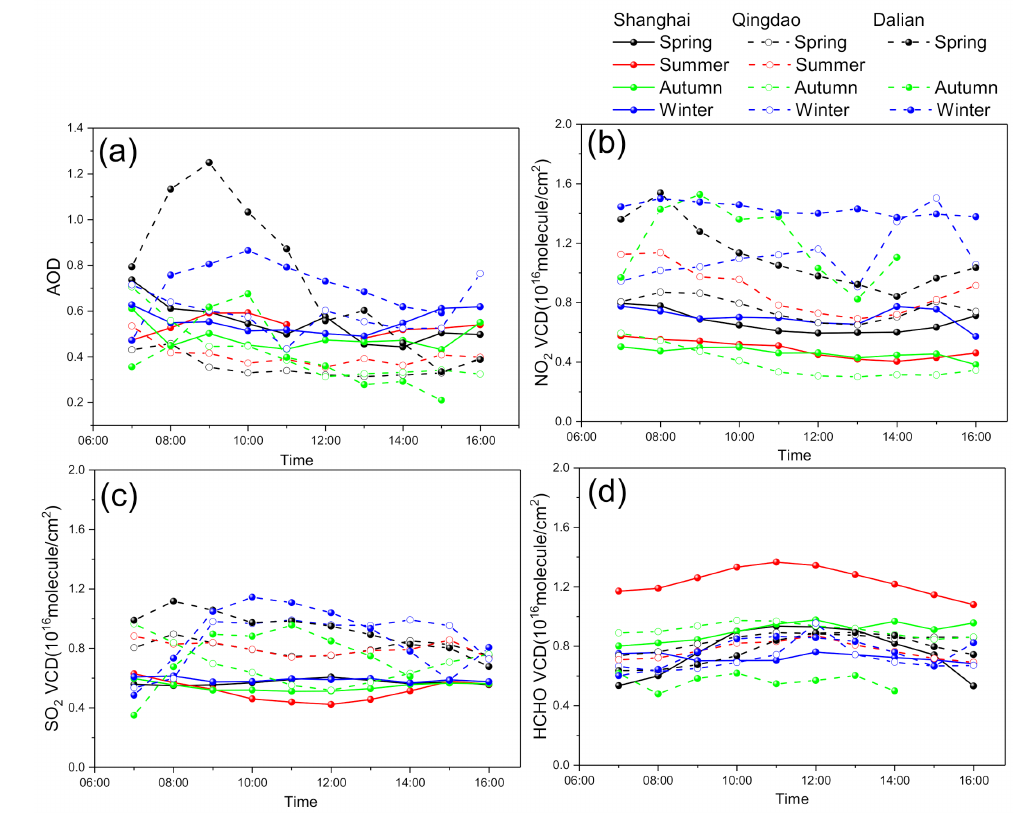
Figure 6. Seasonally averaged diurnal variations of AOD ( a ) and trace gas VCDs for NO 2 ( b ), SO 2 ( c ) and HCHO ( d ) in different seasons in Qingdao, Shanghai, and Dalian.